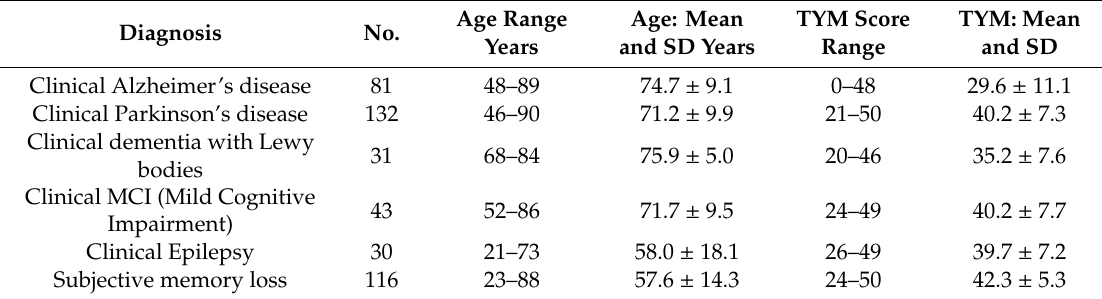
Table 2. Characteristics and TYM test results of patients with various diseases in a general neurology clinic. The diagnoses were